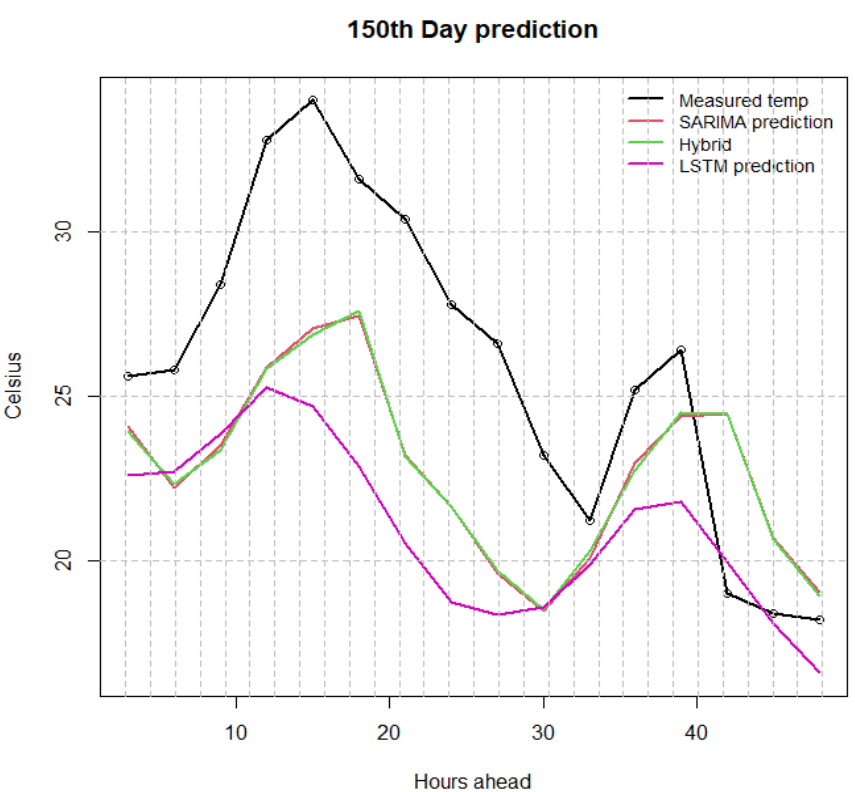
Figure 7. Comparison of SARIMA, LSTM and hybrid with real data on temperature example for 2-day prediction horizon in April; example with very big MAE.